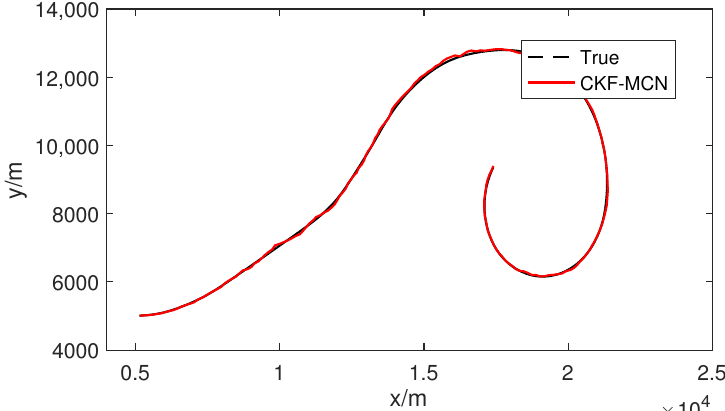
Figure 2. True and estimated trajectories by using CKF-MCN.